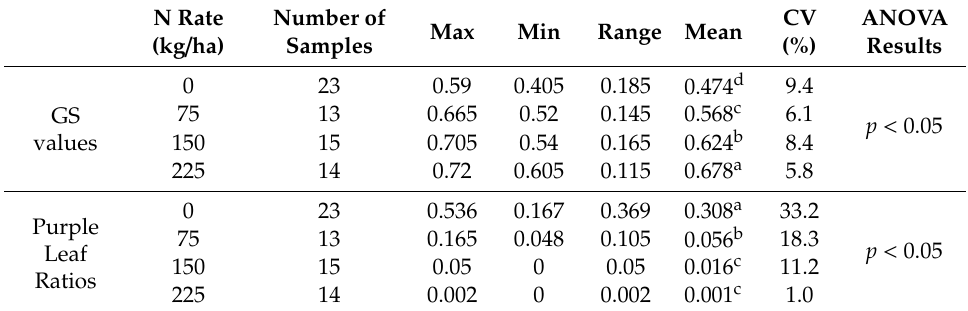
Table 3. Descriptive statistics and the di ff erences of GreenSeeker (GS) values and purple leaf ratios among four N application